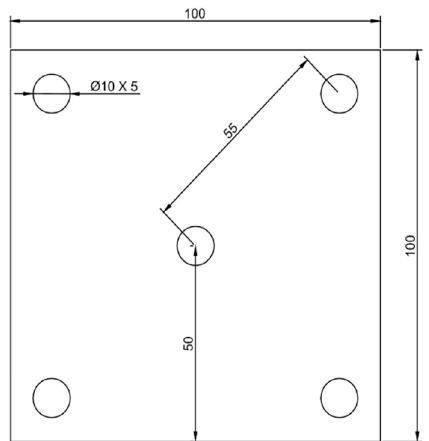
Figure 1. Top view of the workpiece for the circular-patch welding test (unit: mm).